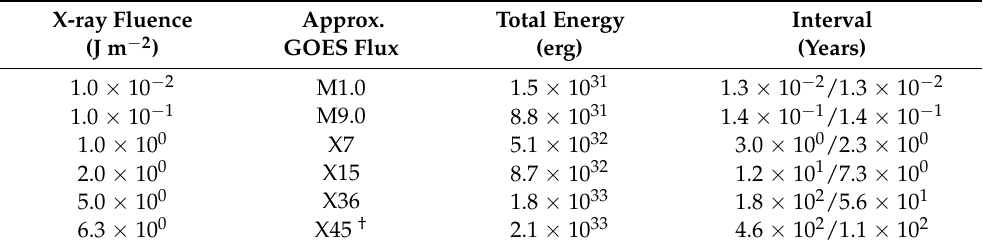
Table 3. Predicted flare intervals as a function of X-ray fluence values (gamma function distribution,